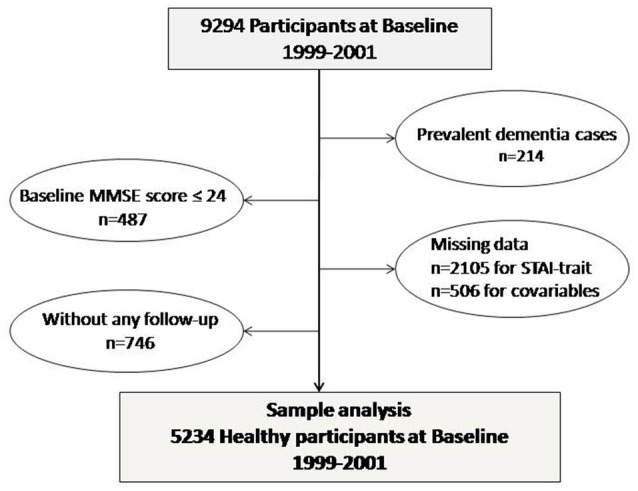
Sample analysis.